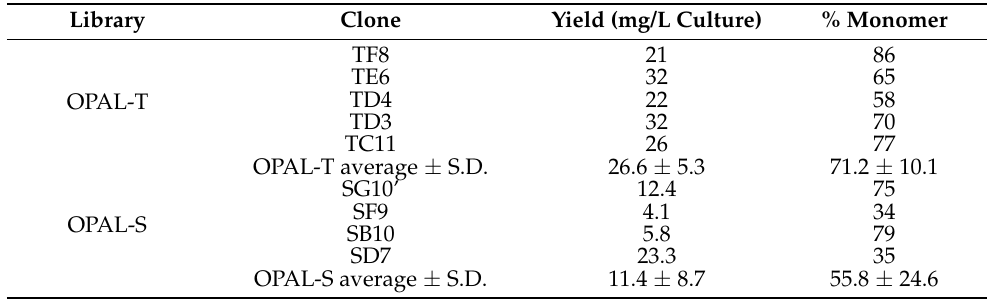
Table 4. Purified yields and monomeric percentages of anti-hNinj1 scFv clones from OPAL-T and